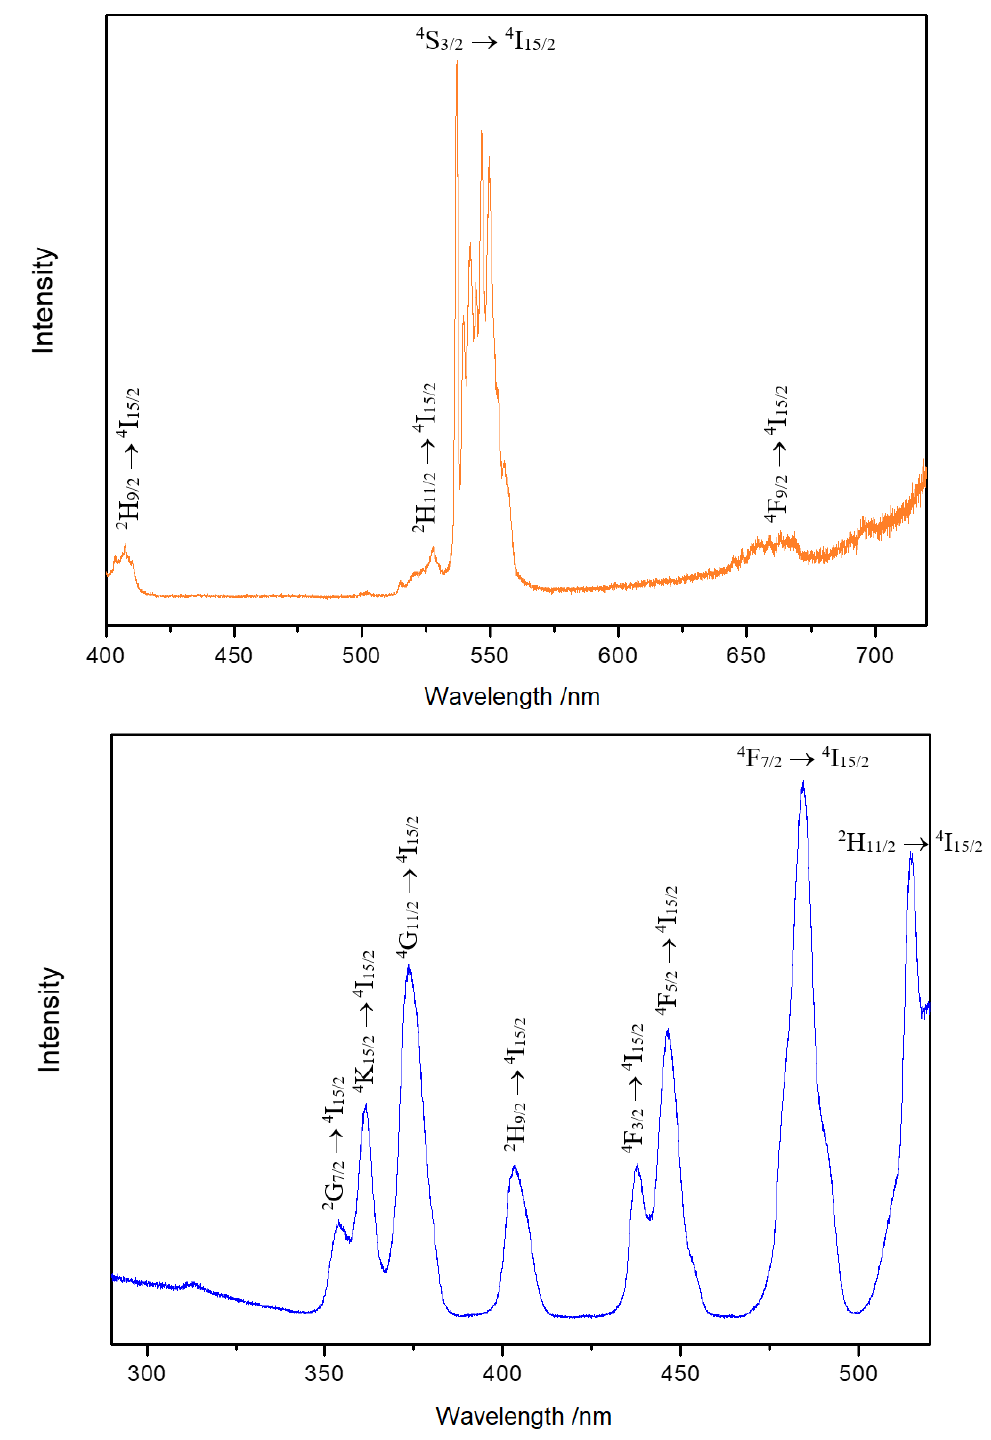
Figure 8. Emission spectrum of Y 3 F[Si 3 O 10 ]:Er 3+ excited at 375 nm at room temperature ( top ). Excita- tion spectrum of Y 3 F[Si 3 O 10 ]:Er 3+ detected at the emission energy of 536 nm at room temperature ( bottom ).